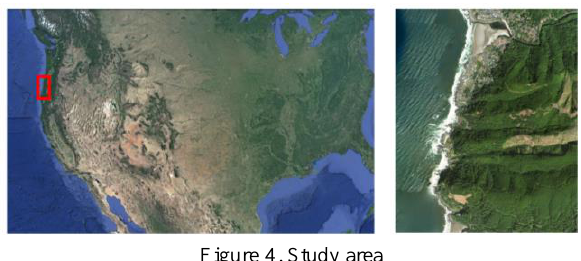
Figure 4. Study area